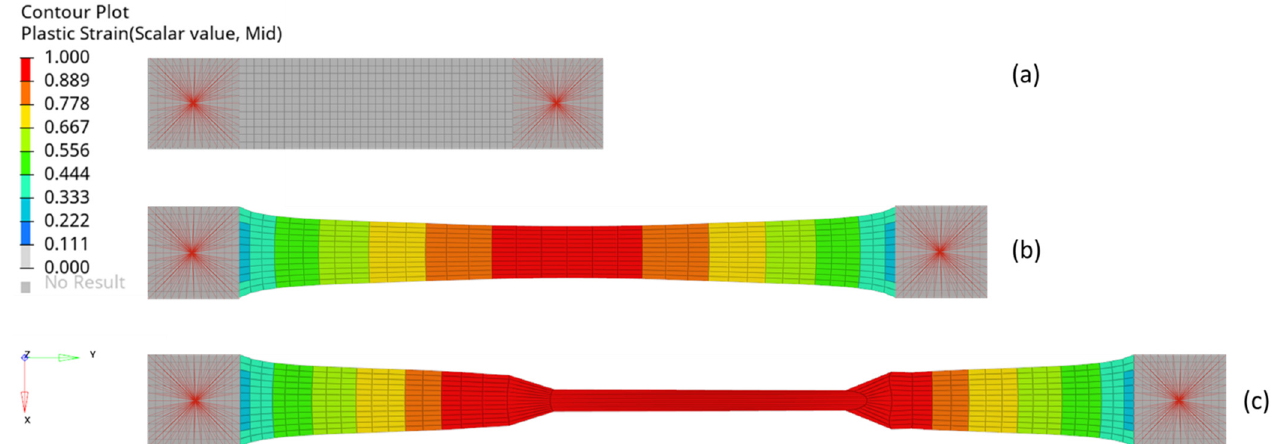
Figure 14. FE results showing the loading phases in the MD direction at initial stage ( a ), short before the first localization occurs ( b ) and further development of the total elongation ( c ).